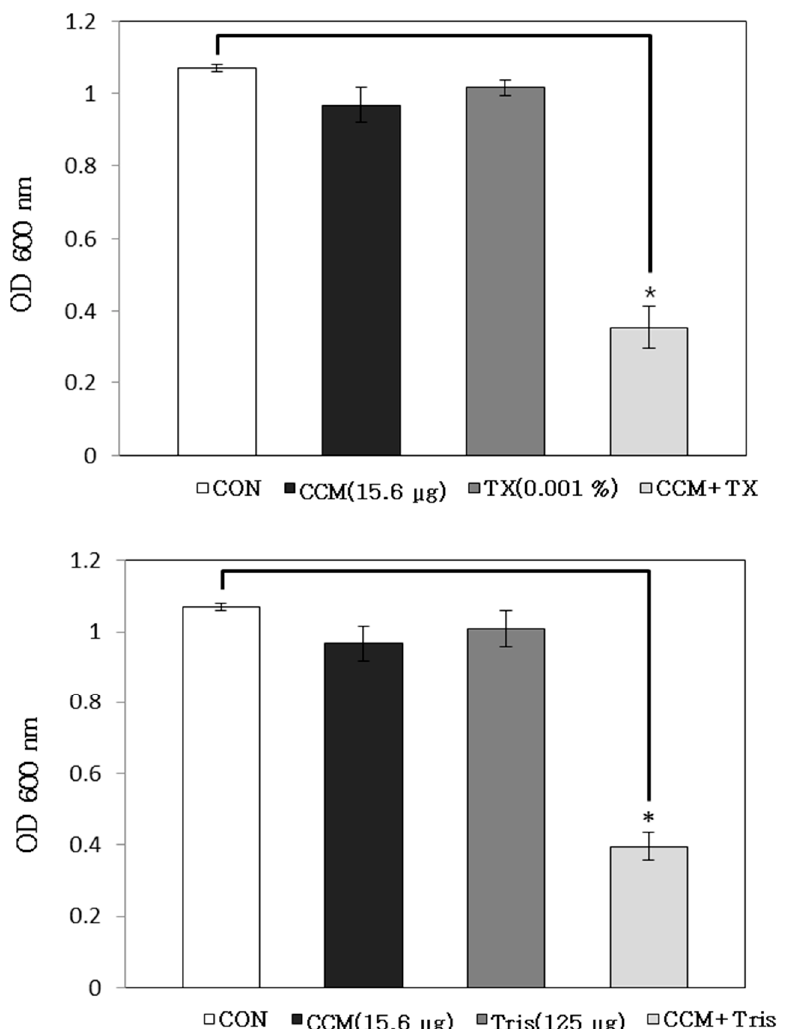
Figure 2. The effects of the membrane-permeabilizing agents Triton X-100 (TX-100) and tris -(hydroxymethyl) aminomethane (Tris) on the susceptibility of Staphylococcus aureus (ATCC 33591) to curcumin (CCM) treatment. The viability of bacteria was determined via spectrophotometry (optical density at 600 nm, OD 600 ) after incubation for 24 h with 15.6 μ g/mL CCM with 0.001% TX-100 and 125 µg/mL Tris, respectively. These data represent as the average of three independent experiments. * p < 0.05, as compared to CCM alone, were determined. CON is the acronym for the control S. aureus strain, which was not